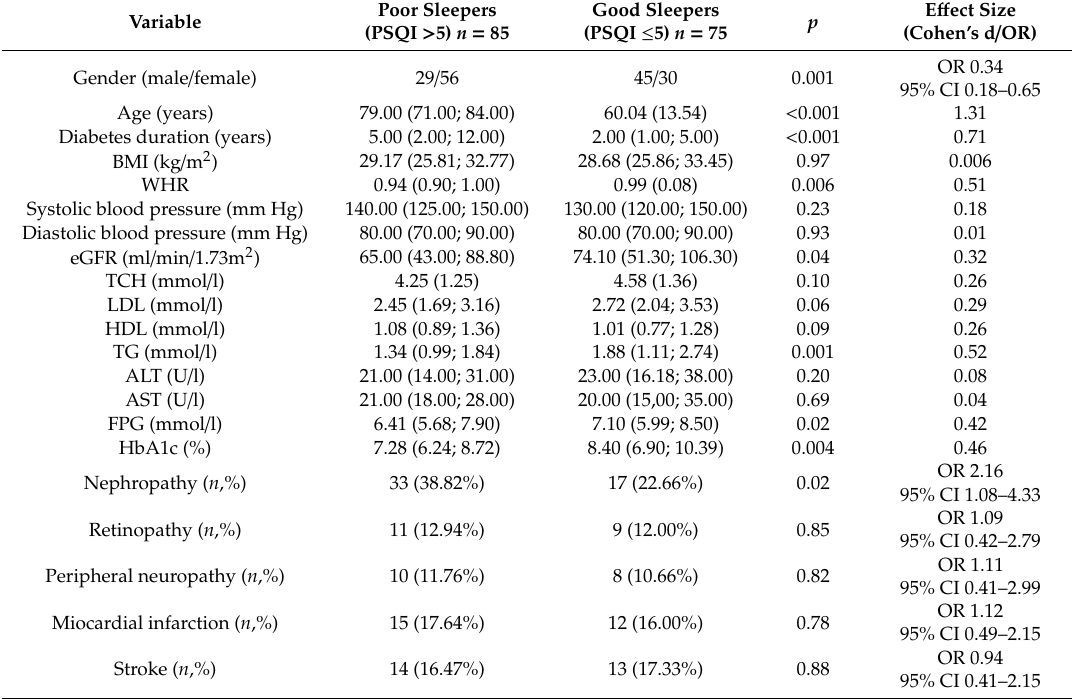
Table 1. Phenotype of poor and good sleepers among T2DM patients.